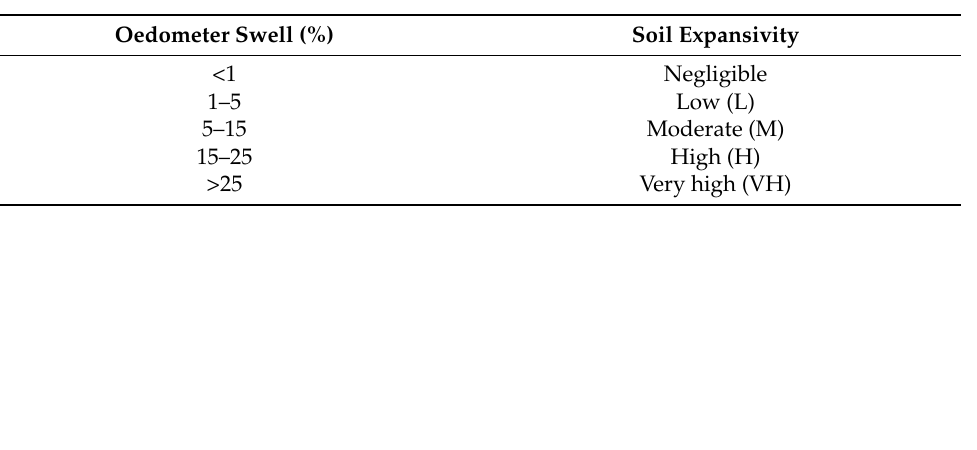
Table 3. Classification procedures for expansive soils. Adapted with permission Sridharan and Prakash (2000) [138] © ICE Publishing